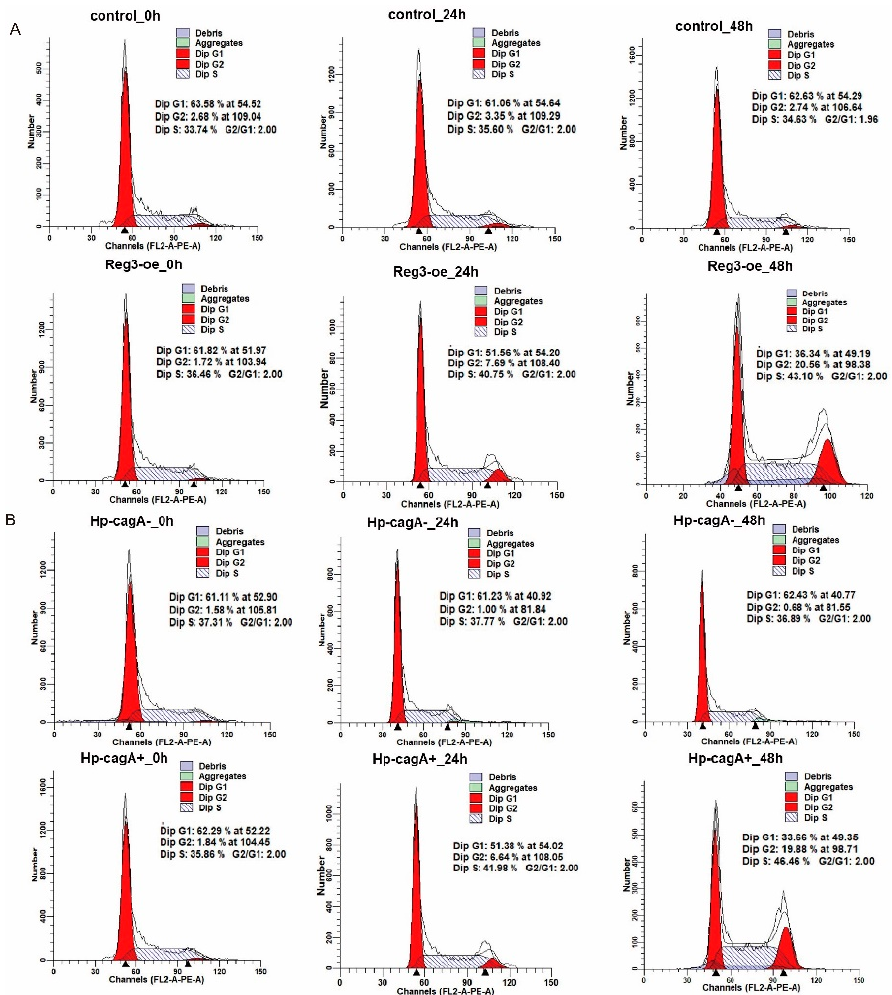
Figure 4. CagA and reg3 alter the cell cycle. ( A ). cell cycle changes were assessed after the upregulation of reg3 in gastric cancer cells. ( B ). cell cycle changes were assessed after H. pylori infection of gastric cancer cells.